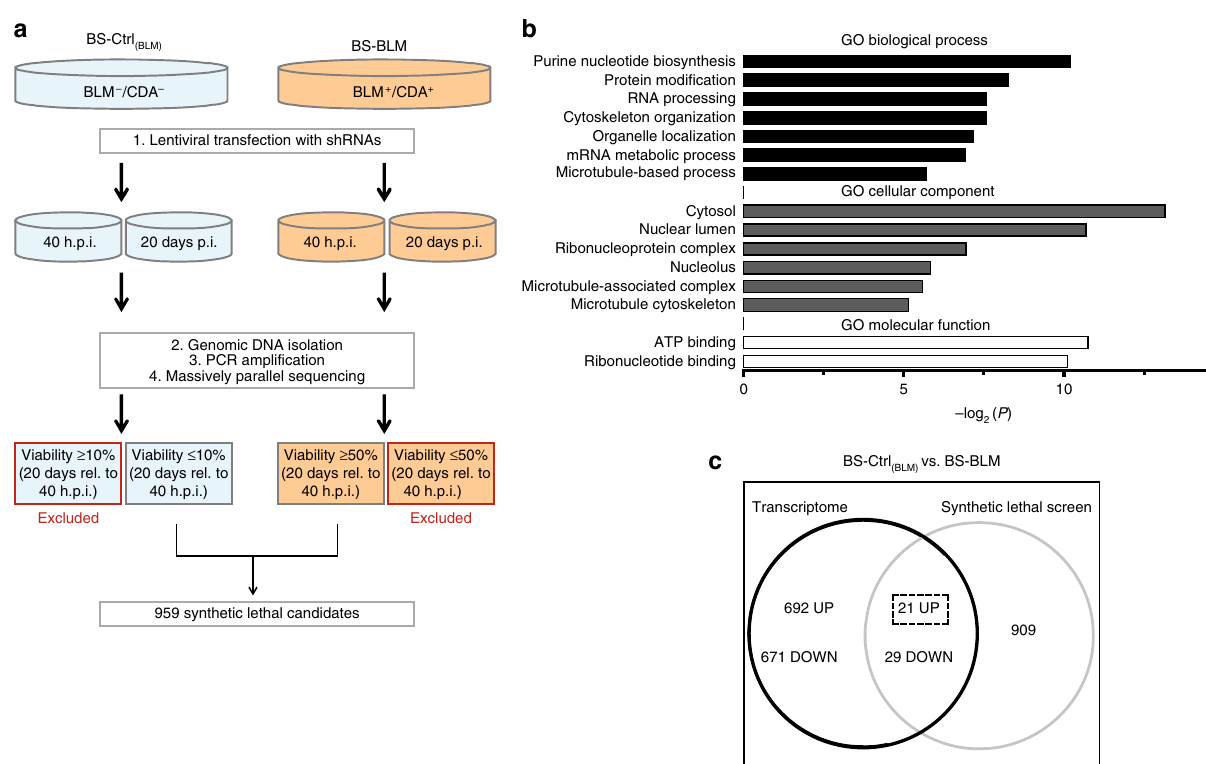
Fig. 1 RNAi-based synthetic interaction screen. a Schematic representation of the genome-wide shRNA-screening procedure. Brie fl y, the screening involved four steps: (1) transduction of BS-Ctrl (BLM) and BS-BLM cells with a library of pooled lentiviral human shRNAs; (2) isolation of genomic DNA from cell populations 40 h or 20 days post-infection ( p.i .); (3) PCR ampli fi cation of isolated genomic DNA; (4) quanti fi cation of shRNA populations by barcode sequencing. b Identi fi cation of pathway enrichment for the list of 959 synthetic lethal genes, with the DAVID database. The x axis corresponds to – log 2 ( P ). GO Gene Ontology. c Venn diagram showing mRNAs identi fi ed as differentially expressed in BS-Ctrl (BLM) and BS-BLM cells, and the number of mRNAs concomitantly synthetic